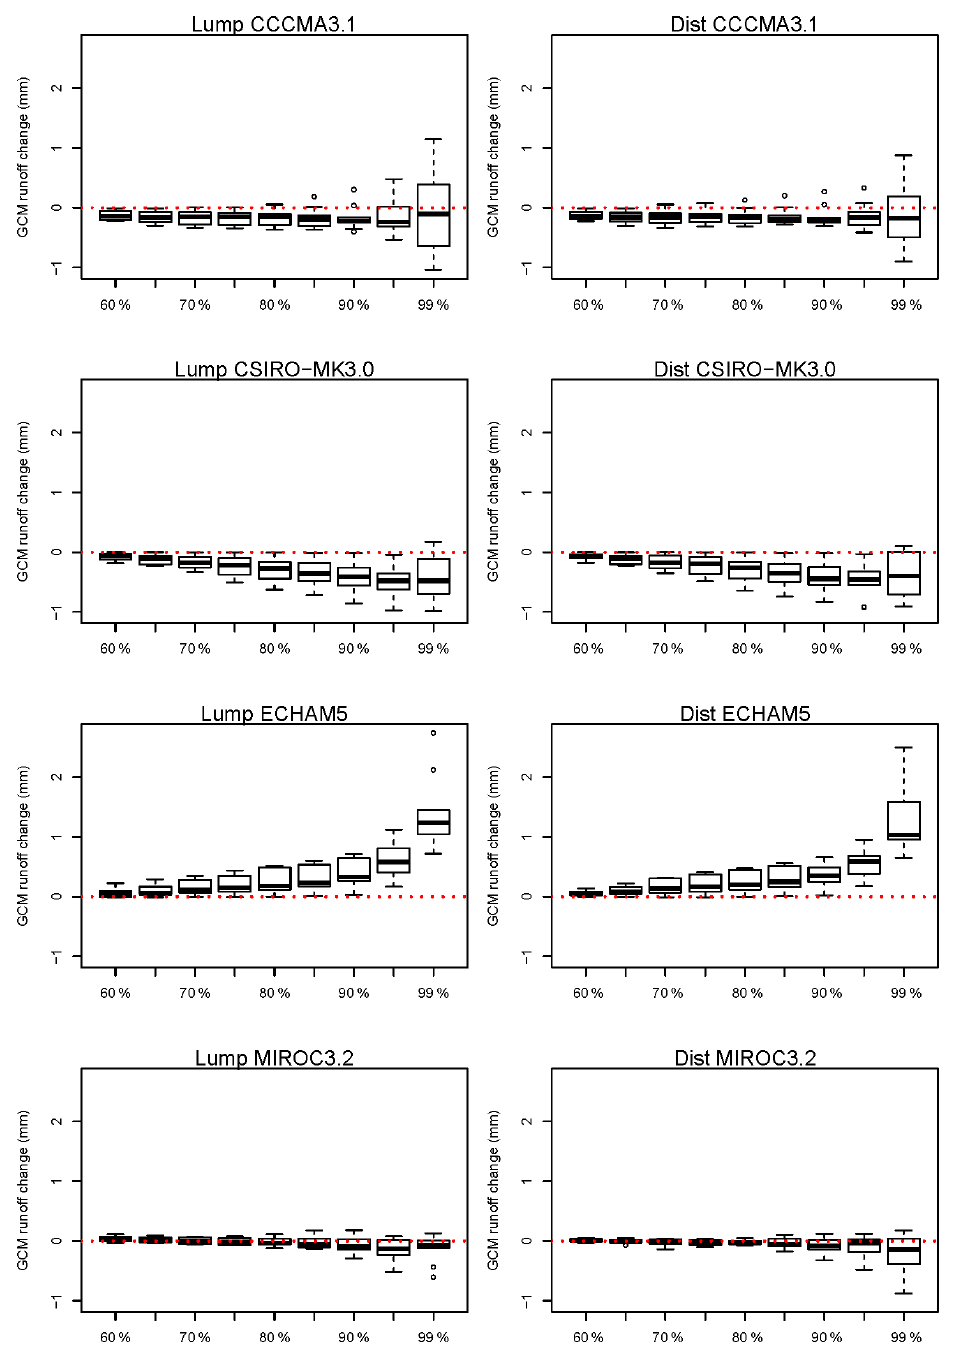
Figure 10. Simulated climate change runoff high-flow percentile changes (future minus historical using WRF-BC rainfall) of the 60th to 99th daily percentiles for lumped (left) and distributed (right) simulations. Box plots show the range across the 10